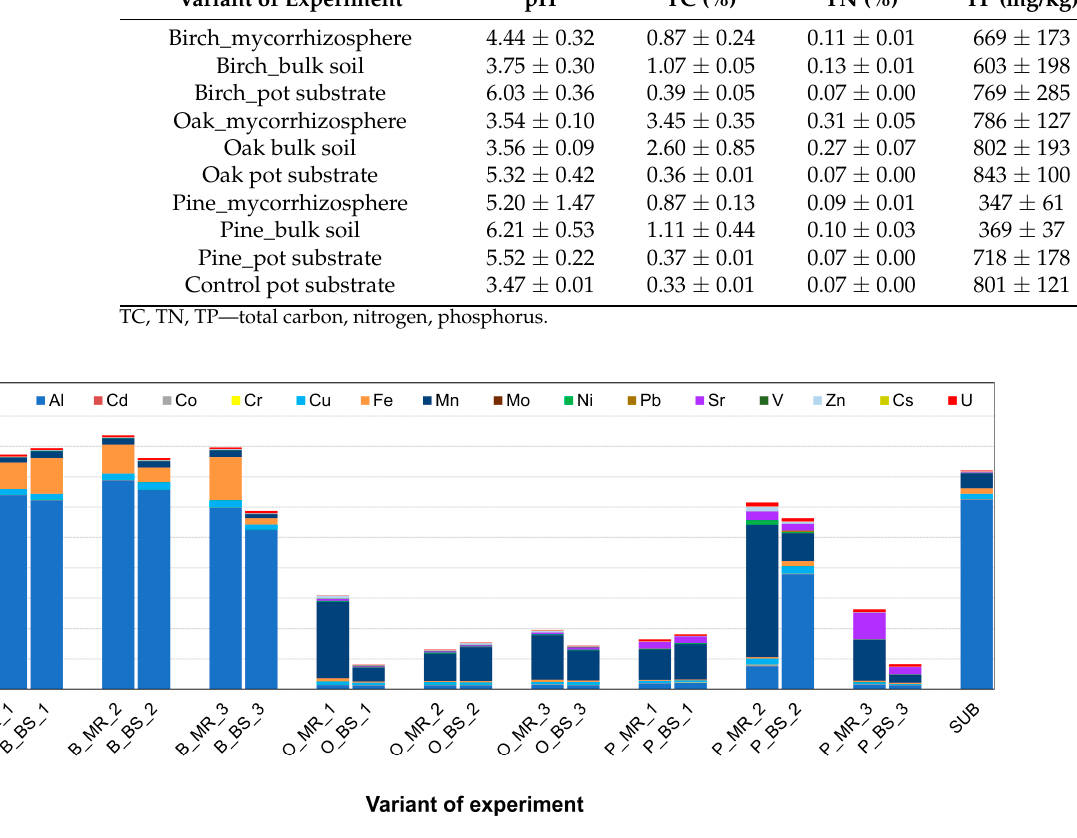
Figure 4. Sum content of toxic metals’ bioavailable fractions determined in test field soil. B—birch,